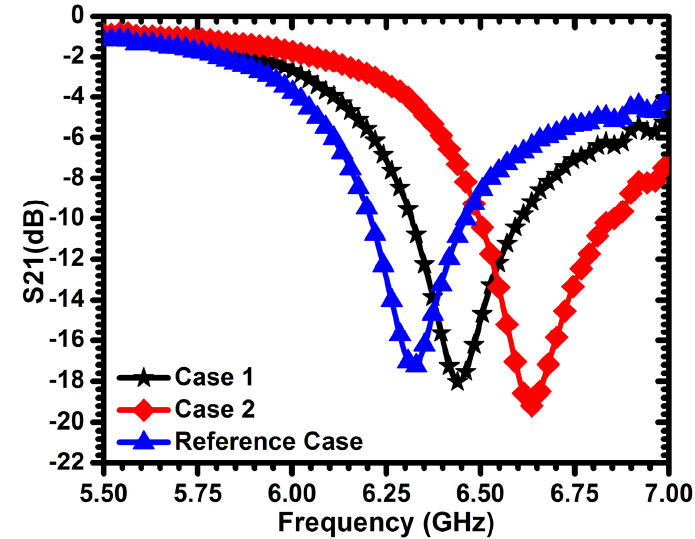
Figure 19. Minimum transmission of the sensor for a crack width (w) of 150 µ m (Case 1) and 200 µ m (Case 2) compared with solid dielectric material (fiberglass) with a dielectric constant of 2.3 (reference case). The crack depth (h) is 1 . 5